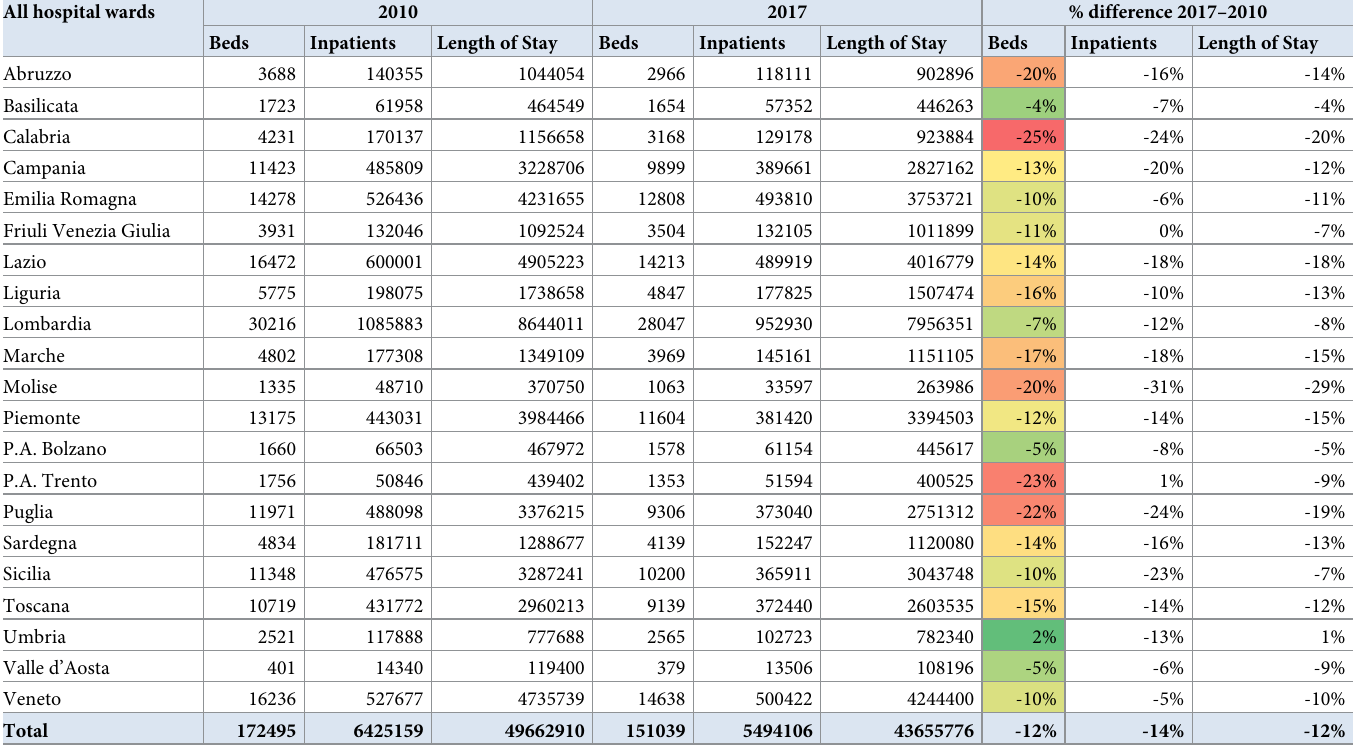
Table 1. Number of hospital beds, hospitalization and length of stay in the years 2010 and 2017 highlighting the differences in each Italia region. All hospital